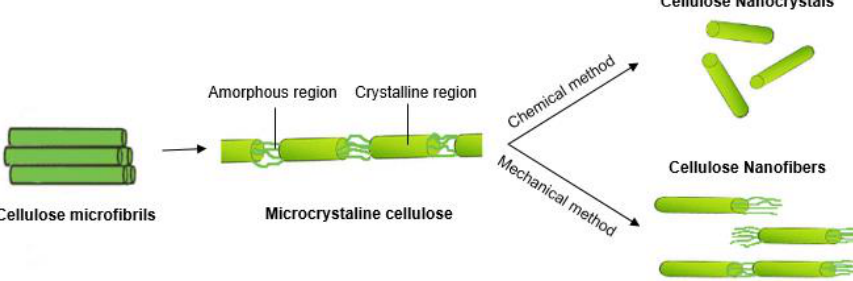
Figure 4. Microcrystalline cellulose (MCC) and nanocellulose (CNC and CNF) production from cellulose microfibrils.